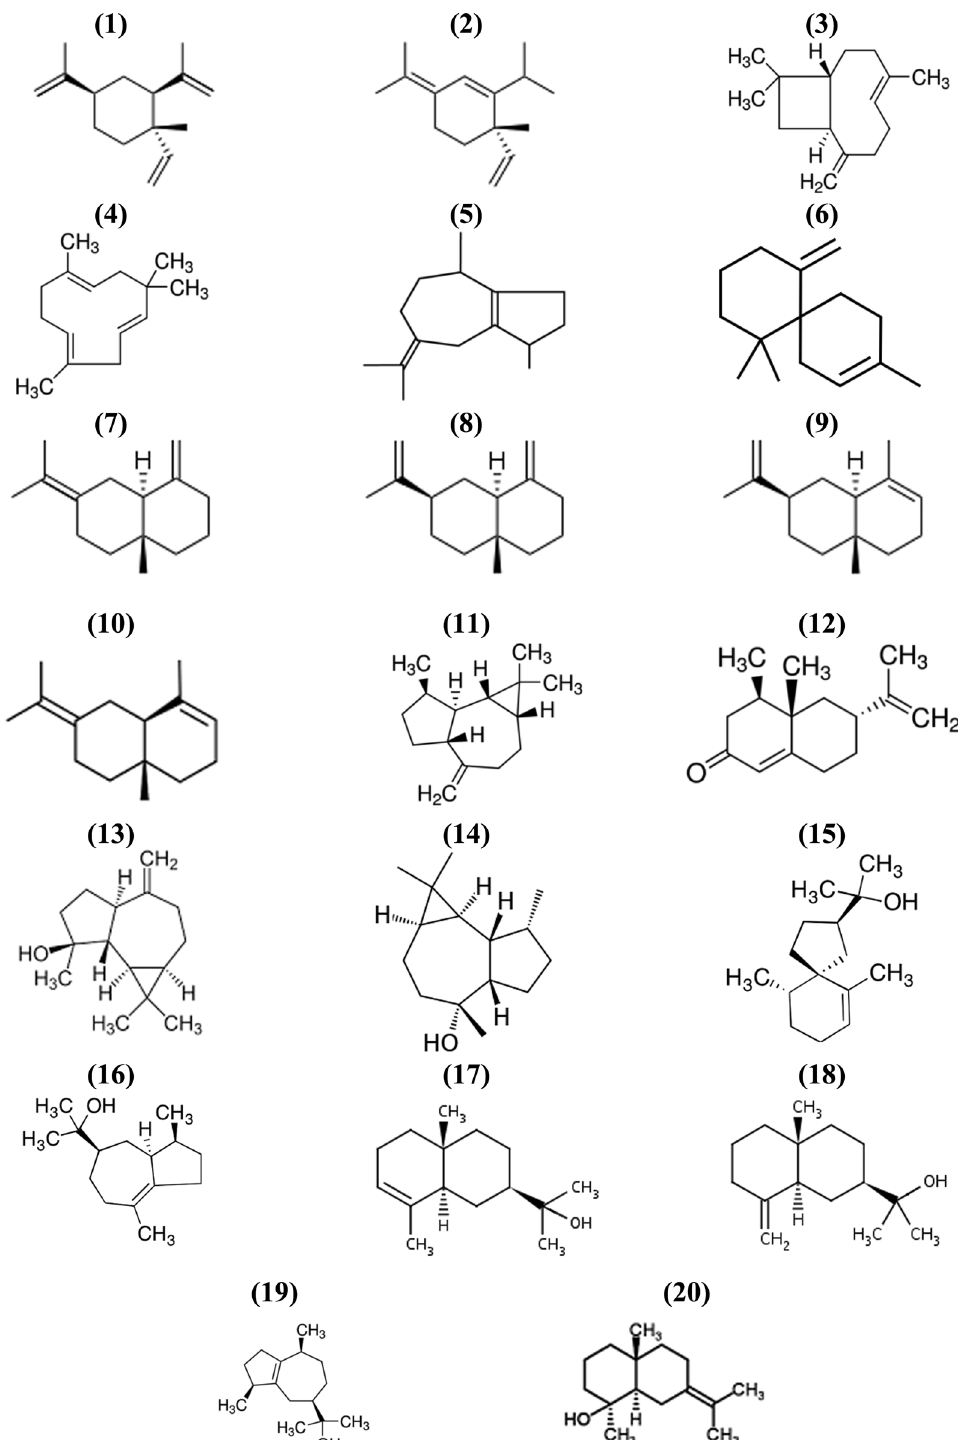
Figure 3: Chemical structures of identi fi ed terpenoid compounds: ( 1 ) β - elemene, ( 2 ) α - elemene, ( 3 ) trans -( − ) caryophyllene, ( 4 ) α - humulene, ( 5 ) α - guaiene, ( 6 ) β - chamigrene, ( 7 ) γ - selinene, ( 8 ) β - selinene, ( 9 ) α - selinene, ( 10 ) 3,7 ( 11 )- selinadiene, ( 11 ) (+) aromadendrene, ( 12 ) (+) nootkatone, ( 13 ) spathulenol, ( 14 ) ledol, ( 15 ) hinesol, ( 16 ) bulnesol, ( 17 ) α - eudesmol, ( 18 ) β - eudesmol, ( 19 ) guaiol, ( 20 ) juniper